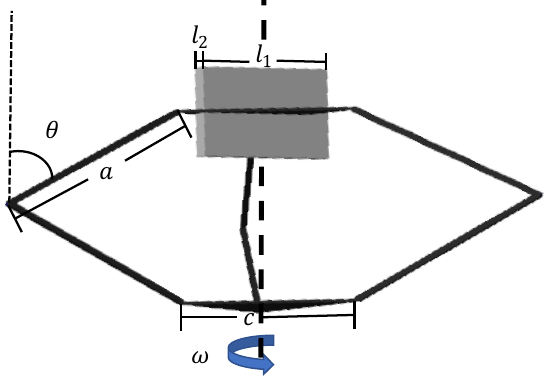
Figure 9. Schematics of the modified model for the IAT.